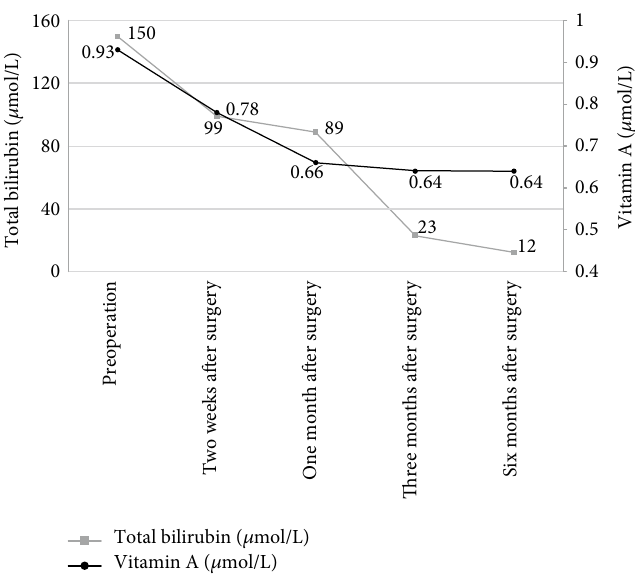
Figure 2: Relationship between FSV levels and bilirubin changes before and after surgery in patients with BA. The median serum vitamin A level did not increase postoperatively. It was 0.93, 0.78, 0.66, 0.64, and 0.64 μ mol/L before surgery, 2 weeks after surgery, and 1, 3, and 6 months after surgery, respectively; these values were within the normal range (0.52 – 2.20 μ mol/L). The TB level decreased gradually postoperatively. It was 150.5, 99.25, 89, 22.6, and 12 μ mol/L before surgery, 2 weeks after surgery, and 1, 3, and 6 months after surgery, respectively, showing no signi fi cant di ff erence between the two groups. Thus, although the bile fl ow was established after surgery and the TB level remarkably decreased, the vitamin A level did not change signi fi cantly within the short follow-up time after surgery.